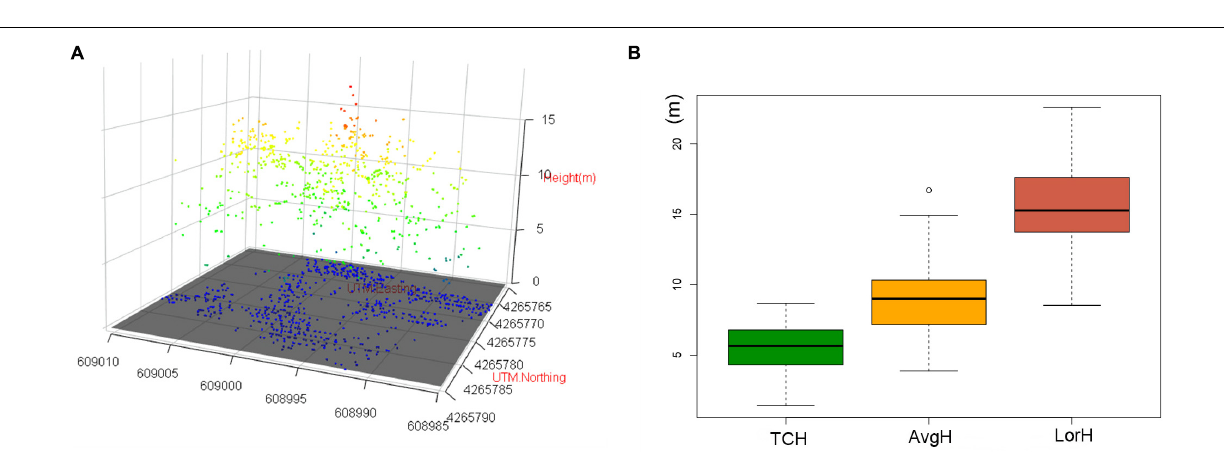
FIGURE 8 | (A) 3D scatter plot of the normalized point cloud (NPC) in plot 1. (B) Boxplots of TCH, AvgH and LorH. White bullet is mild outliers of boxplot.